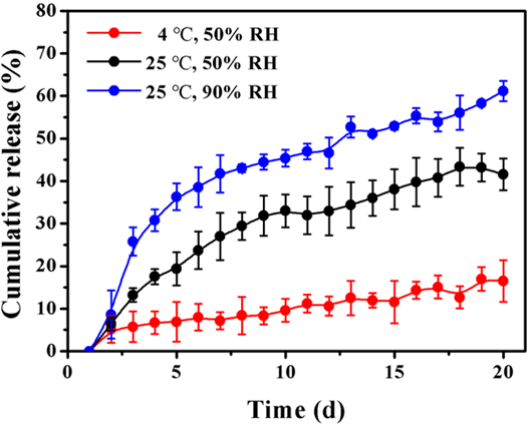
Figure 5. In vitro release of thymol from PLGA microparticles at 25 °C (50% RH), 25 °C (90% RH), and 4 °C (50% RH). Error bars indicate the standard deviation of the mean.